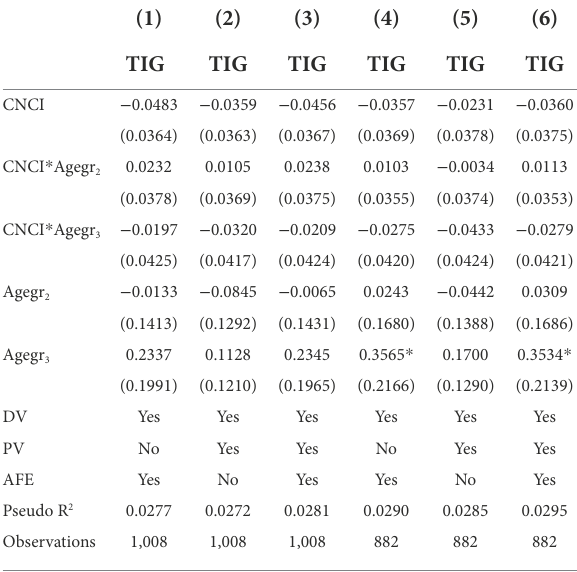
TABLE 4 Pseudo treated